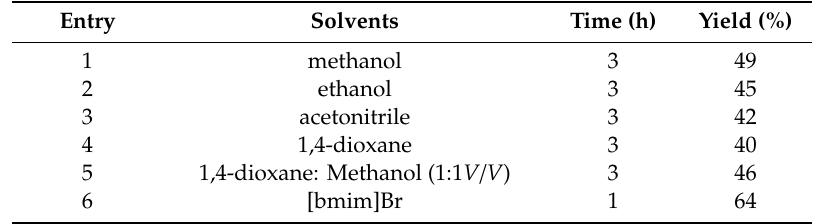
Table 1. Solvent optimization of cycloadduct 8j .